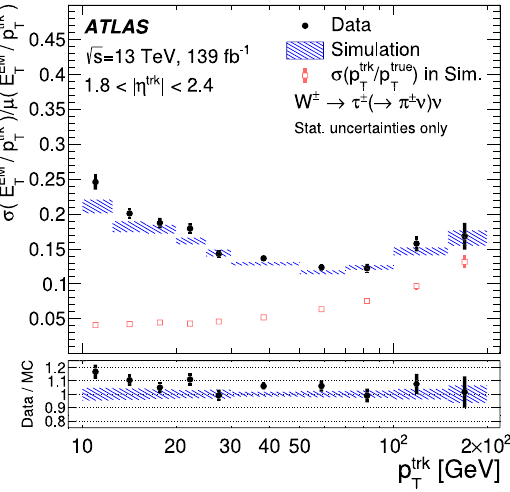
/ p trk lation to give an illustration of the contribution to the total width from T T the resolution of reconstructed tracks. The uncertainties shown are only those from the limited number of events in the dataset and simulated samples